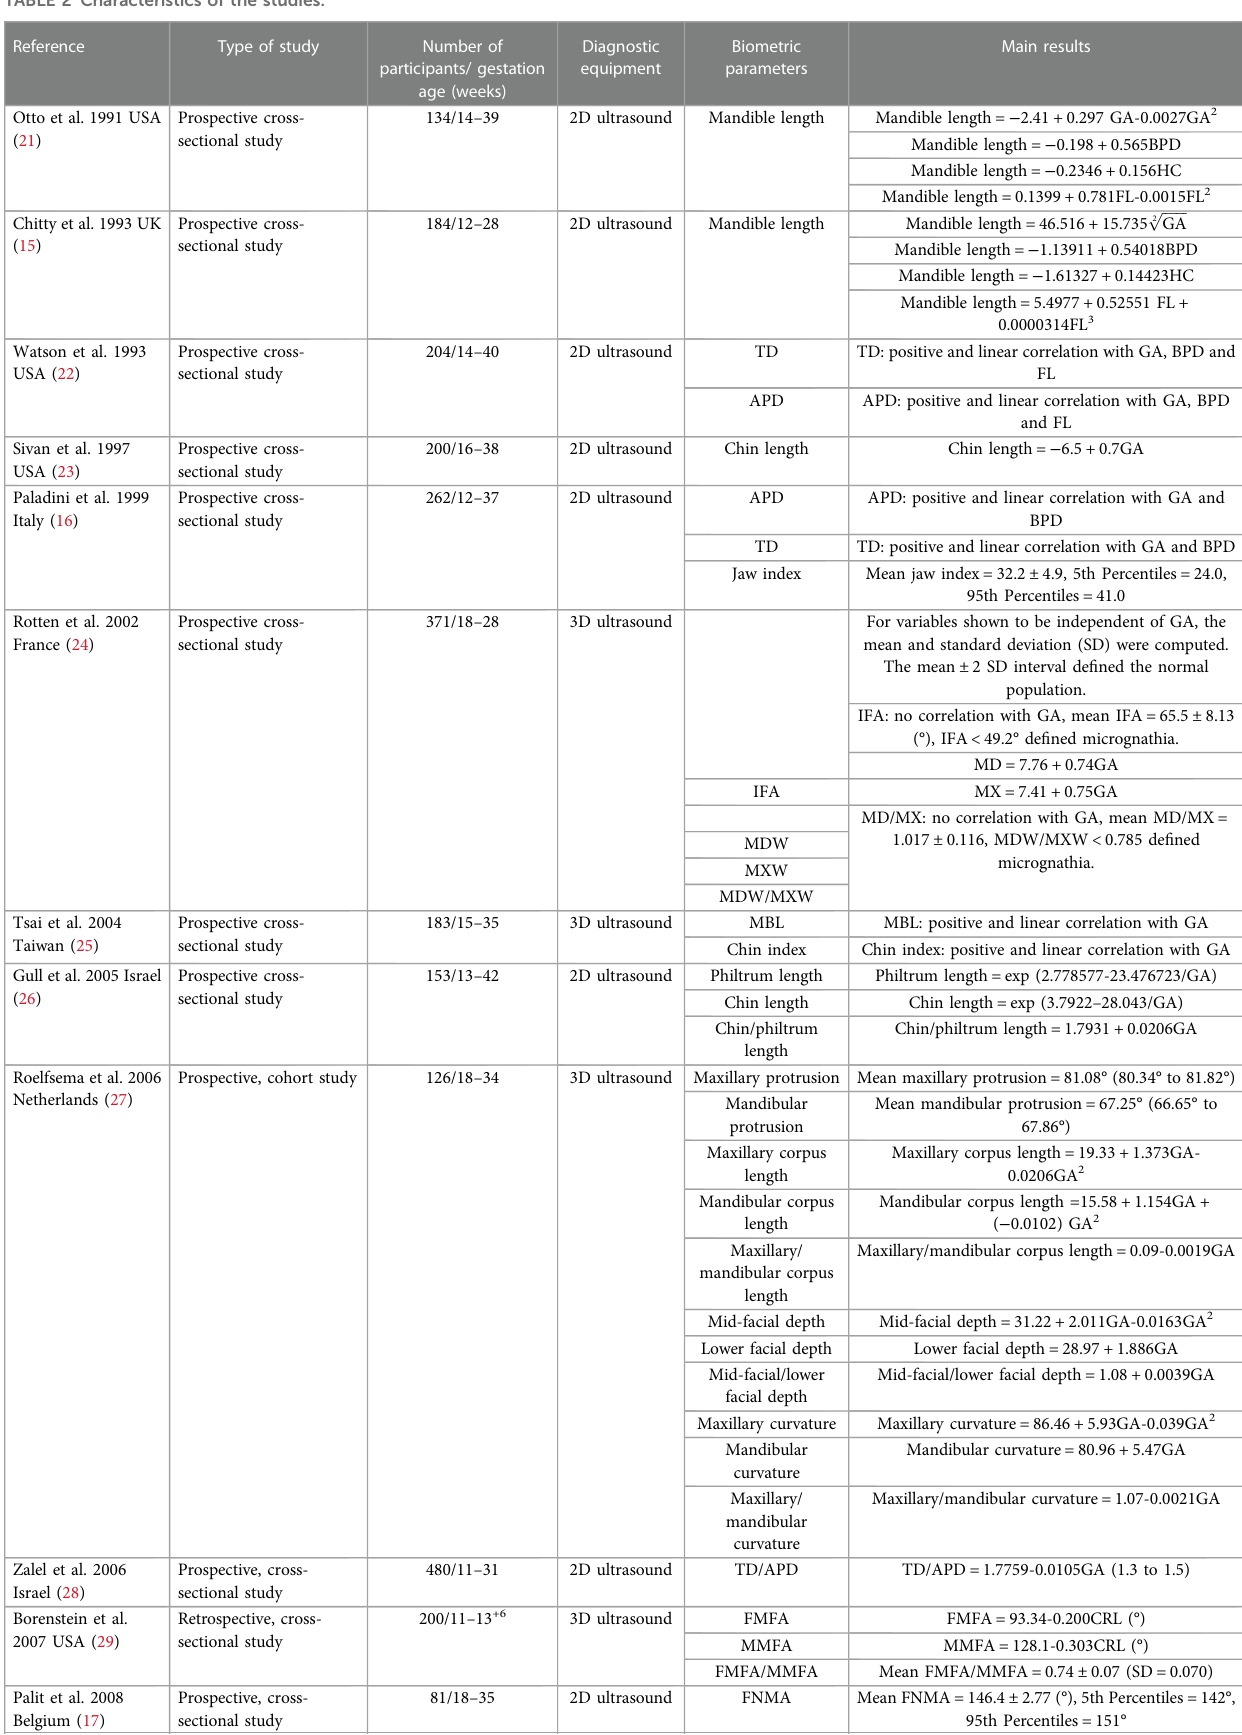
TABLE 2 Characteristics of the